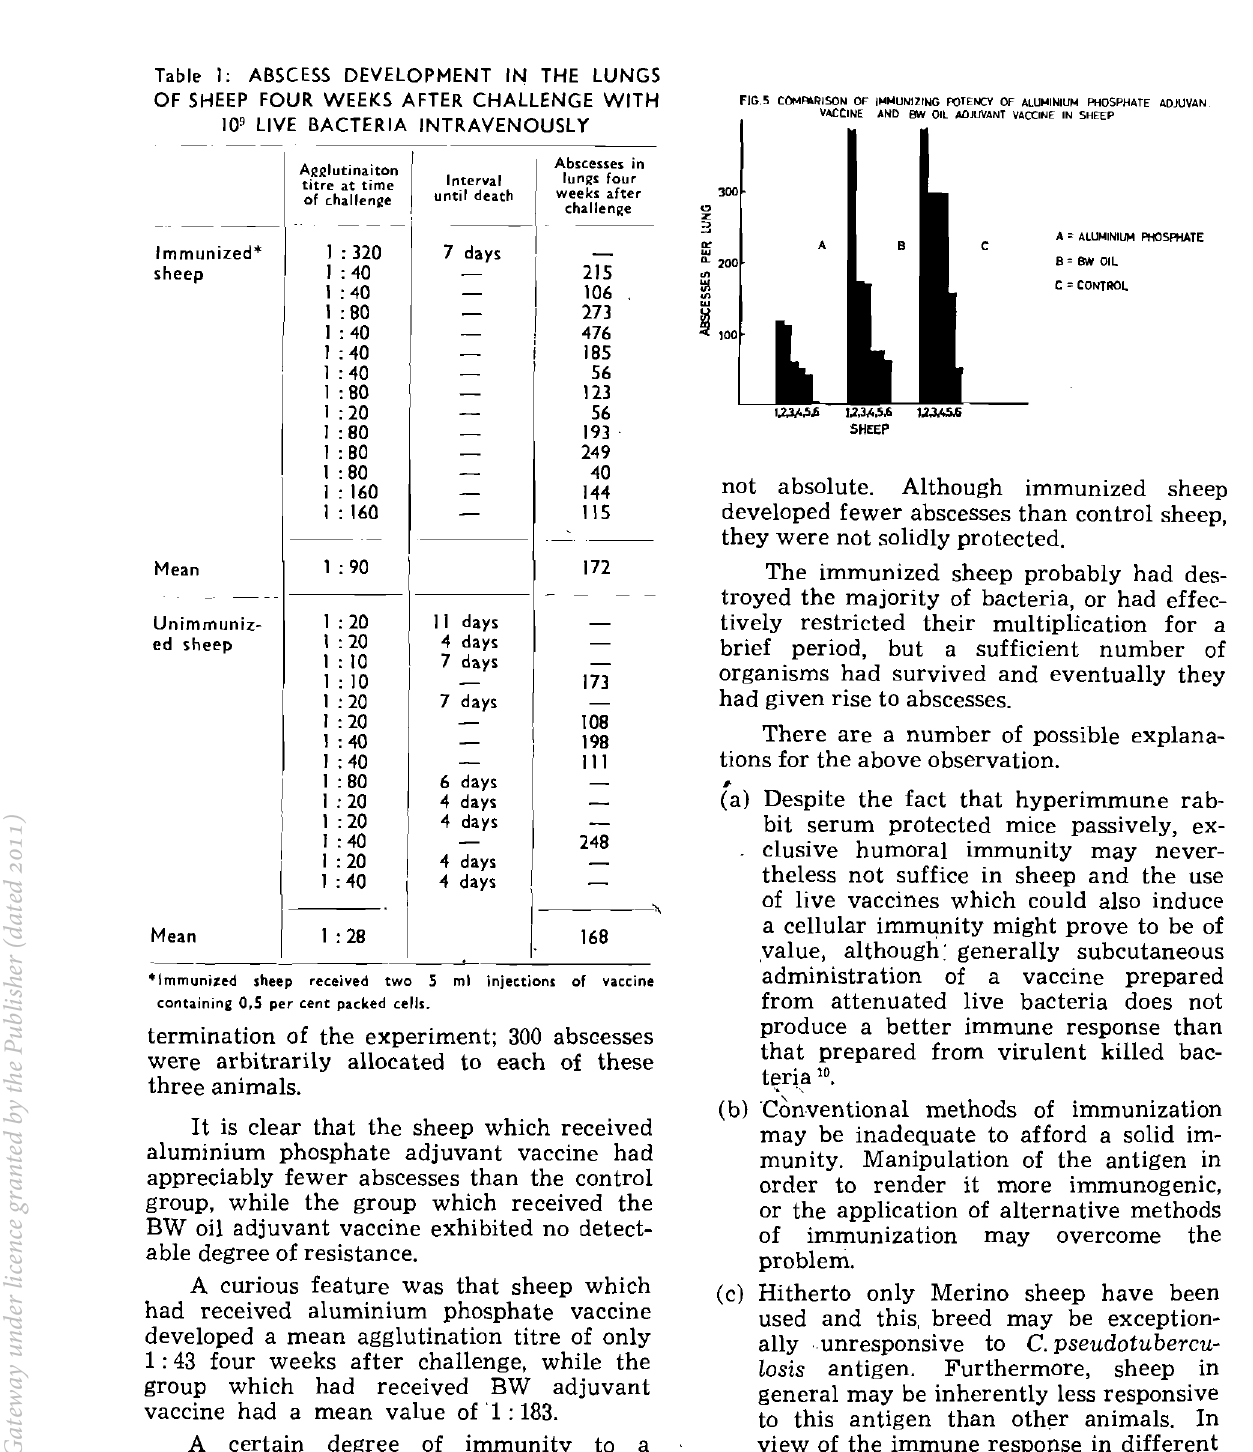
FIG.S COMRtRISON OF I .... UNIZING F'OTENCY OF AW .. INIU" PHOSPHATE AOJUVAN. VACCINE AN!) fJN OIL ADJUVANT VACCINE IN SHEEP